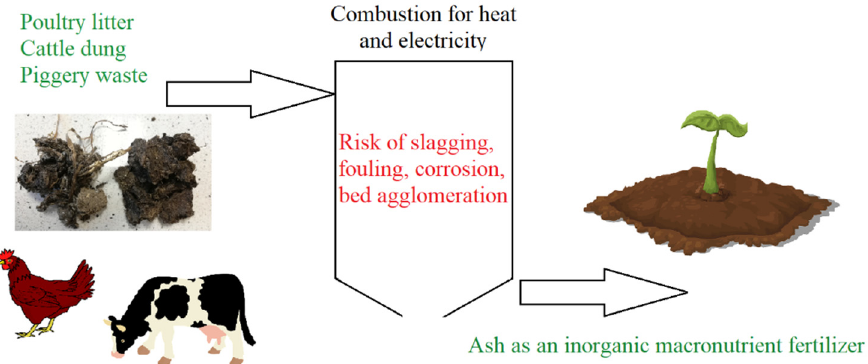
Figure 1. Scheme of energy recovery and nutrient recycling from animal waste.